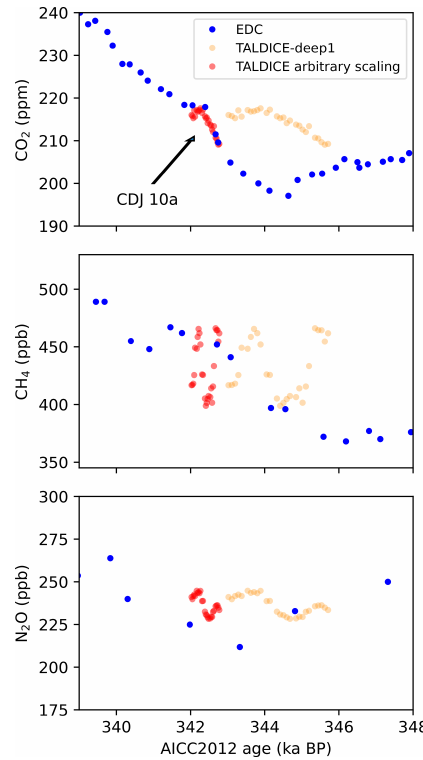
Figure 12. Comparing our high-resolution Talos Dome data to EDC records. EDC CO 2 and CH 4 from Nehrbass-Ahles et al. (2020) in- cluding carbon dioxide jump 10a and N 2 O (Spahni et al., 2005) are plotted on the AICC2012 age scale (Veres et al., 2013), which is also the basis for TALDICE-deep1 (Crotti et al., 2021). The Talos Dome data are shown both on the TALDICE-deep1 age scale and on an arbitrary scaling that optimizes the fit to the EDC